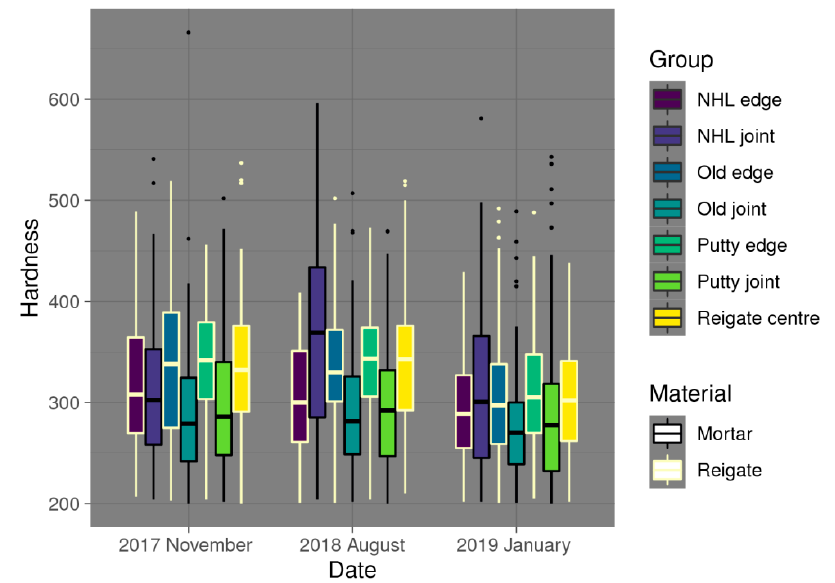
Figure 7. Boxplot of surface hardness measurements across three separate surveys, organised by mortar type and adjacent Reigate block edge (or centre). Central line represents mean value, upper and lower extents of box represent interquartile range (IQR: all measurements within 25th and 75th percentile). Whiskers represent maximum range of measurements less than 1.5 × IQR, outliers are single measurements more than 1.5 × IQR. Only includes data used in ANOVA tests (i.e., measurements taken from same locations across all three surveys). Whilst Reigate centres and edges adjacent to putty and old mortar joints respond similarly to seasonal variation, and corresponding mortar joints follow general pattern, edges adjacent to NHL mortar joints and NHL mortar joints themselves respond differently.